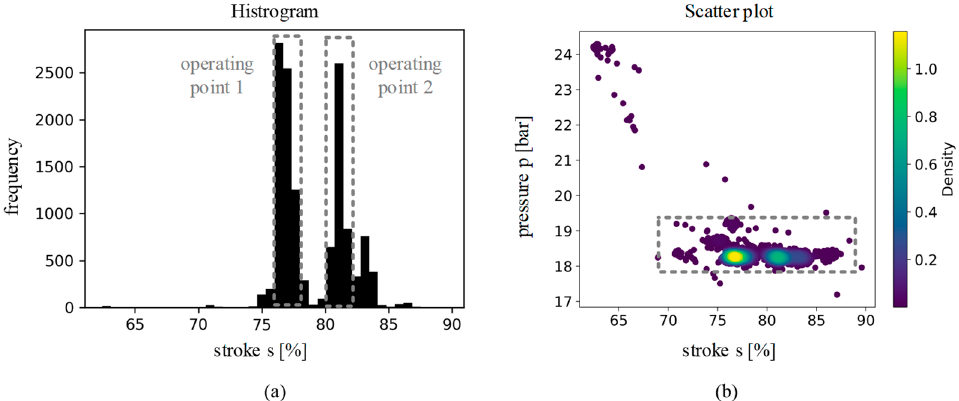
Figure 1. Data of a control valve in a timeframe of 3 weeks of normal operation in an industrial process plant ( a ) histogram of stroke and ( b ) scatter plot of stroke and pressure.